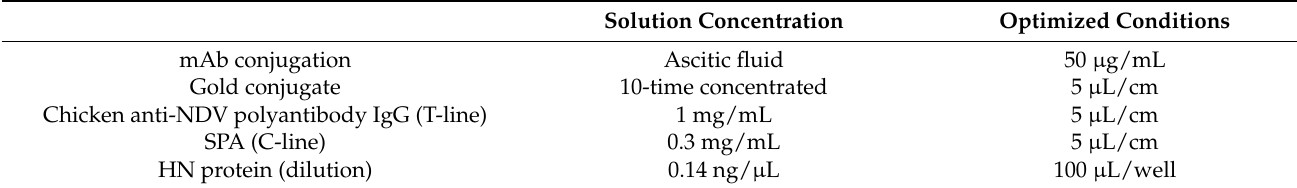
Table 2. Optimized conditions of the bLFA strip for NDV antibody